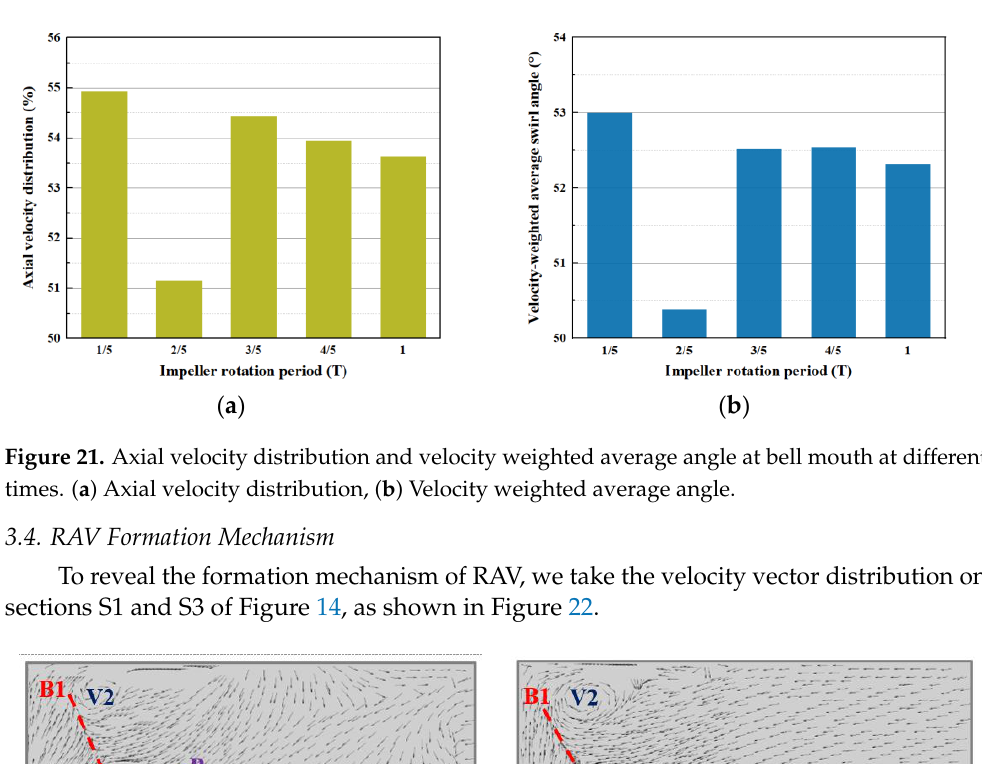
Figure 20. Pressure distribution at the bell mouth at different time points. ( a ) 1/5T. ( b )